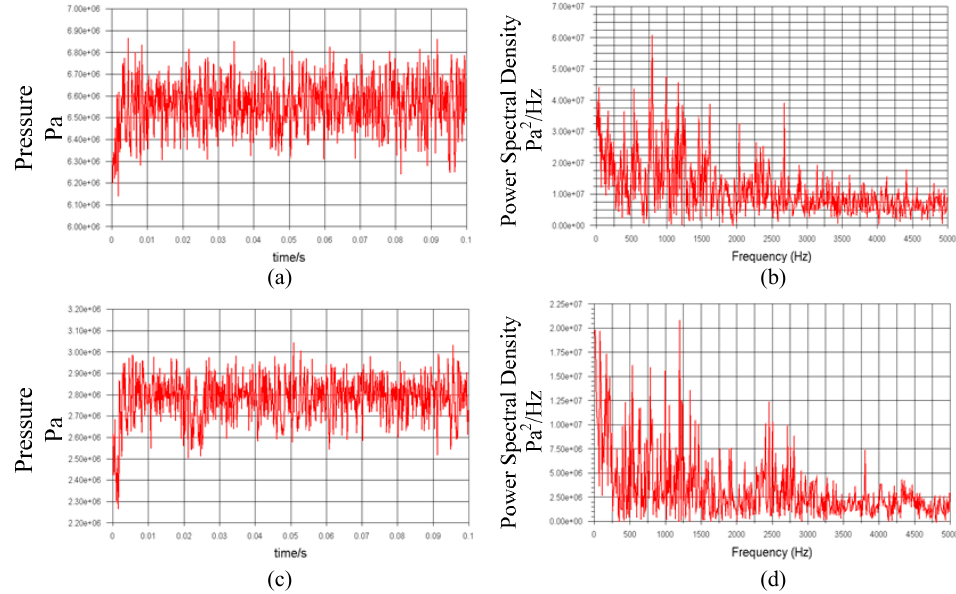
Figure 25. Pressure oscillation curve of the flapper under the influence of the main valve when the displacement of the flapper is x = 0.05 mm. ( a ) Point 1 in the time domain. ( b ) Point 1 in the frequency domain. ( c ) Point 2 in the time domain. ( d ) Point 2 in the frequency domain.